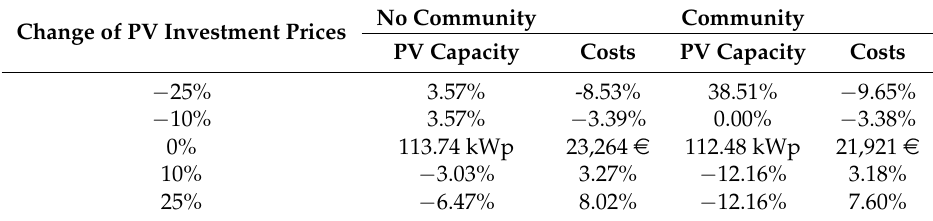
Table 4. Variation of PV investment prices from − 25% to + 25% and the effect on installed PV capacity and the total costs, based on the data of